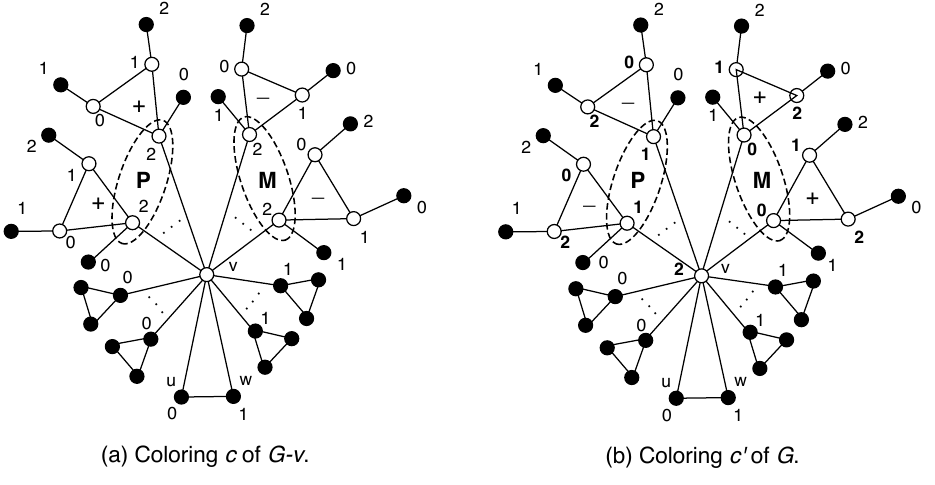
Figure 6: Constructing a 3-coloring of G